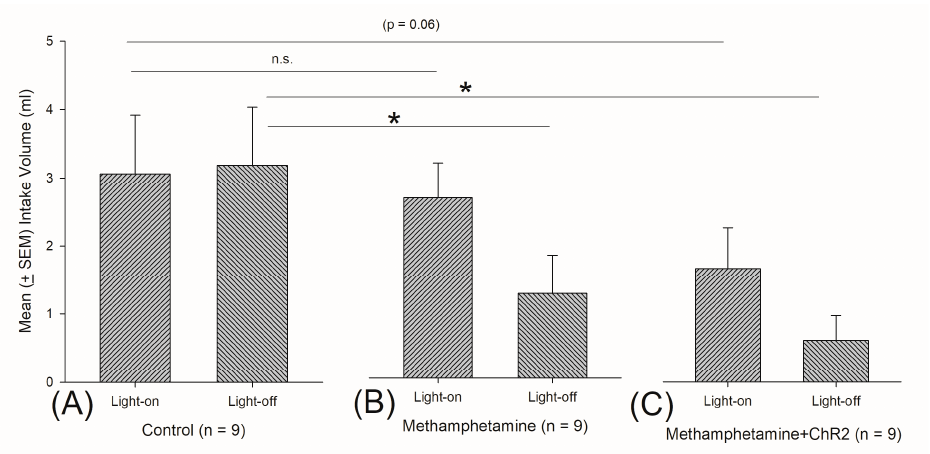
Figure 12. Methamphetamine-induced conditioned taste aversion learning test with ChR2 virus optogenetic photostimulation with LED light-on and light-off. To test conditioned taste aversion learning behavior, the optical fiber was implanted into the medial prefrontal cortex (mPFC). All rats were transfected with ChR2 virus or its control AAV-CaMKIIa-EYFP virus. Later, all of them were respectively assigned into ( A ) control (saline), ( B ) methamphetamine, and ( C ) methamphetamine + ChR2 three groups. All rats were allowed to drink 0.1% saccharin solution for 3 min light-on and 3 min light-off, and then they were intraperitoneally injected with a saline or methamphetamine. The next day, the rats were given the same procedure for drinking 0.1% saccharin solution for 3 min light-on and 3 min light-off in the test phase. The intake volume of saccharin solution was measured for each rat. A dependent t-test was conducted for light-on and light-off in the control, methamphetamine, and methamphetamine-ChR2 groups. The intake volume of LED light-on and light-off was not significantly different for the control (t = − 0.13, p > 0.05), methamphetamine (t = 1.87, p > 0.05), and methamphetamine + ChR2 (t = 1.76, p > 0.05). Furthermore, a 3 × 2 mixed two-way ANOVA was conducted and post hoc tests with light-emitting diode (LSD). To test conditioned taste aversion induced by methamphetamine in behavior, the intake volume of